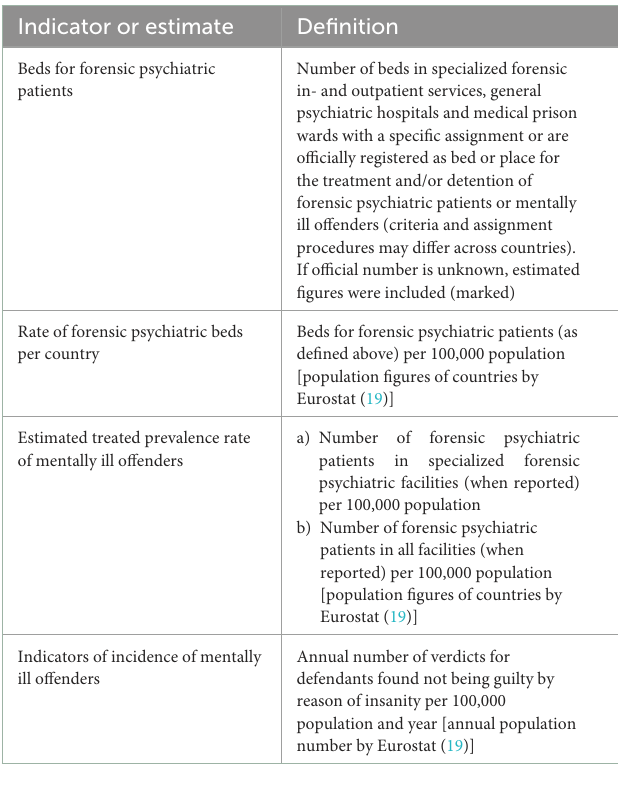
TABLE 1 Indicators and estimates used in this